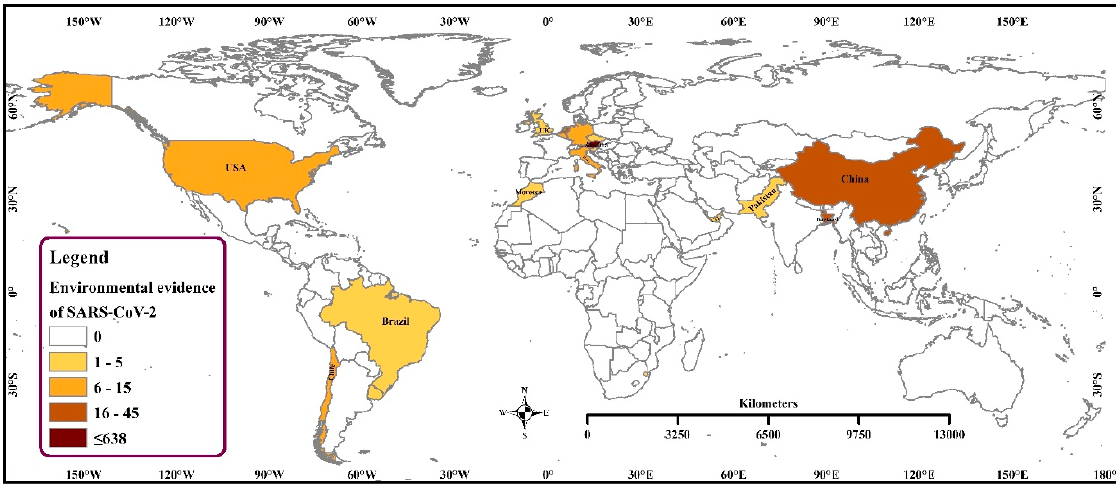
Figure 1. SARS-CoV-2 RNA-detected from diverse environmental samples in different countries in the world.